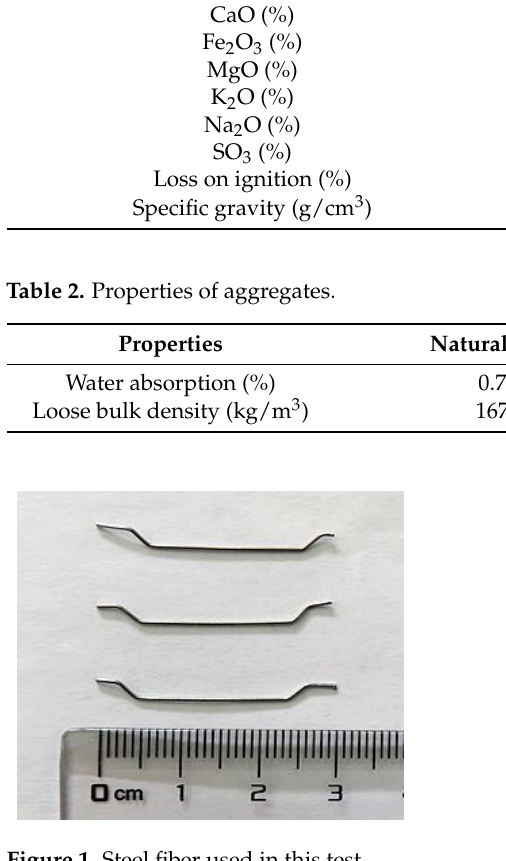
Table 3. Properties of steel fiber.